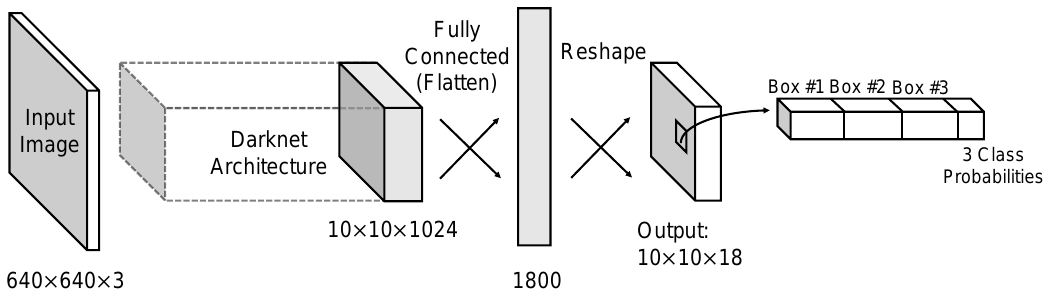
Figure 2. Architecture of YOLO model. The output is a S × S × (5 × B + C) tensor corresponding to the categories, locations, and sizes of objects.